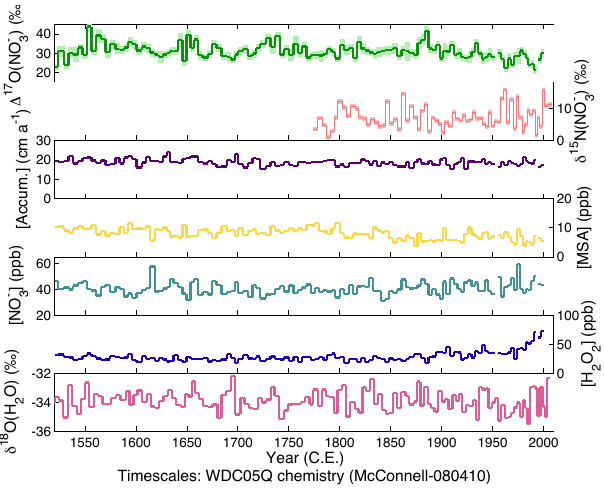
Figure 4. 1m resolution 1 17 O ( NO 3 − ) (WDC05Q core) and δ 15 N ( NO 3 − ) (WDC05A) compared to measurements of accumu- lation rate (WDC05Q), MSA concentration (WDC06A), nitrate concentration (WDC06A), and hydrogen peroxide concentration (WDC05Q), averaged to the resolution of the 1 17 O ( NO 3 − ) data. δ 18 O ( H 2 O ) is shown at the resolution of the δ 15 N ( NO 3 − ) data, as they were both measured at 1m resolution on the same core